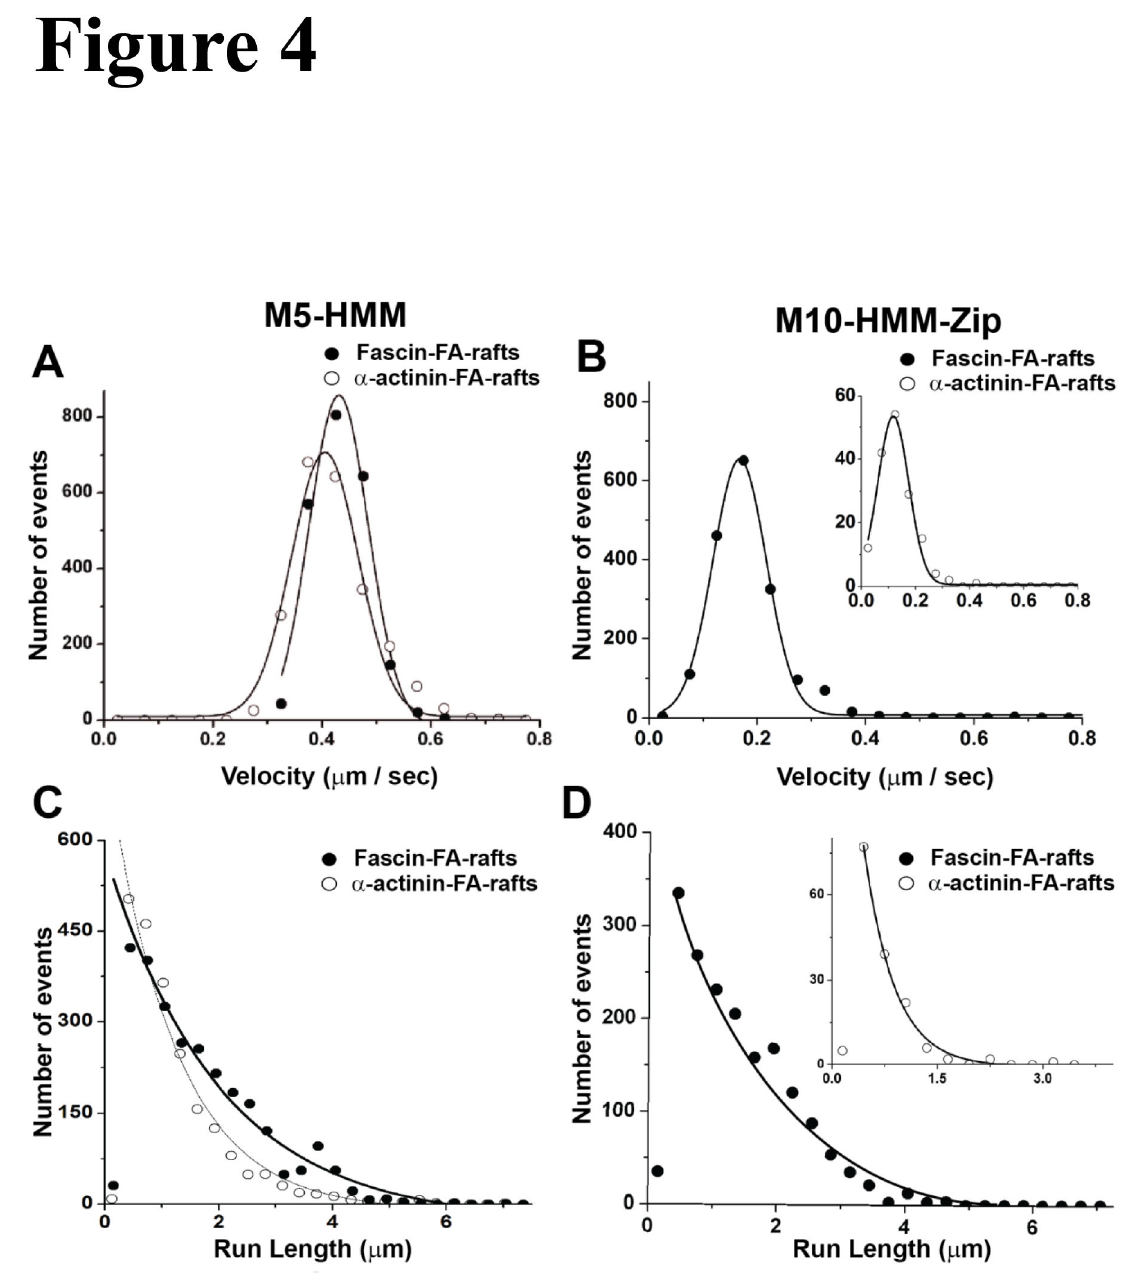
Figure 4. Velocity of m5-HMM and m10-HMM-Zip on 2-D actin rafts with fascin and α-actinin. (A and B) The velocity distributions of m5-HMM (A) and m10-HMM-Zip (B) on 2D F-actin (FA) rafts with α-actinin (open circle) and fascin (closed circle). Solid lines represent a single Gaussian fit to the data. The average velocities of m5-HMM on α-actinin- and fascin-F-actin rafts were 398 ± 88 nm/sec (n = 2355) and 430 ± 144 nm/sec (n = 2200), respectively. The average velocities of m10-HMM-Zip on α-actinin- and fascin-F-actin rafts were 124 ± 36 nm/sec (n = 157) and 165 ± 43 nm/sec (n = 1633), respectively. (C and D) The run-length of m5-HMM (C) and m10-HMM-Zip (D) on 2D-actin rafts with α-actinin (open circle) and fascin (closed circle). The run-lengths of m5- HMM on F-actin rafts with α-actinin (open circle) and fascin (closed circle) were 998 ± 87 nm (n = 2335, means ± S.D.) and 1255 ± 135 nm (n = 2200, means ± S.D.), respectively. The run-lengths of m10-HMM-Zip on F-actin rafts with α-actinin and fascin were 564 ± 23 nm (inset: open circle, n = 157, means ± S.D.) and 1465 ± 125 nm (closed circle, n = 1633, means ± S.D.), respectively.